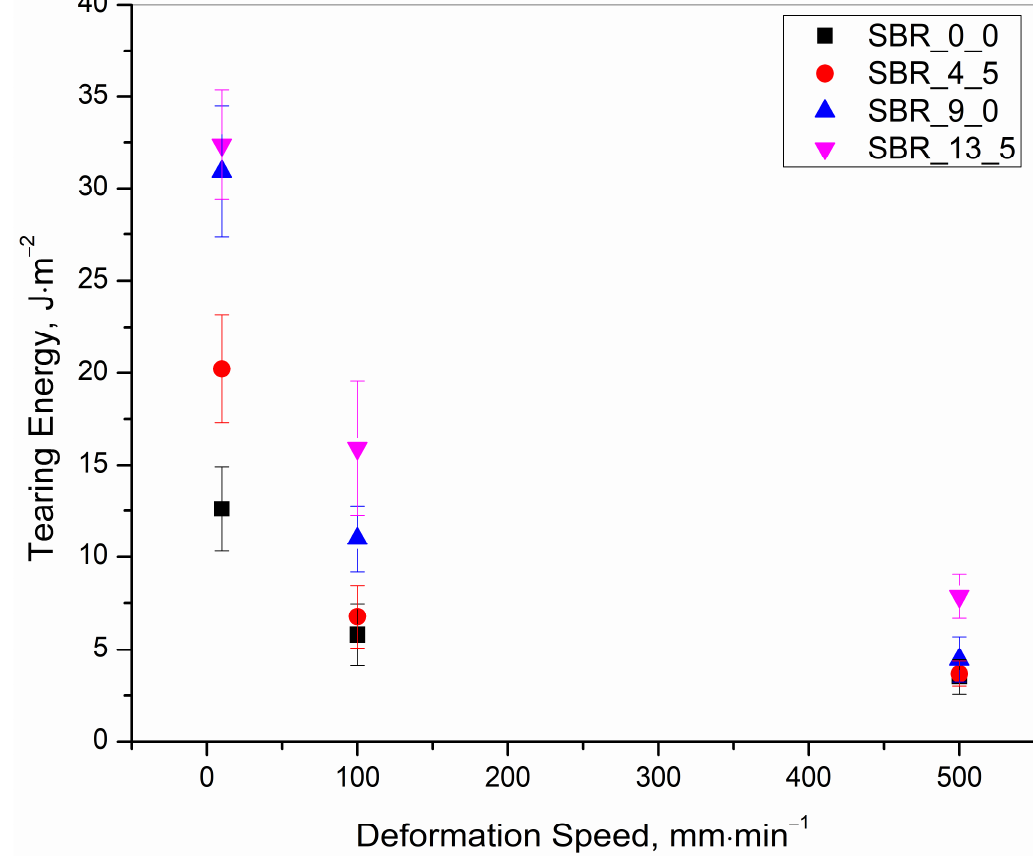
Figure 5. Tearing energy as a function of deformation speed for 0.0, 4.5, 9.0 and 13.5 phr of initial oil incorporated samples.